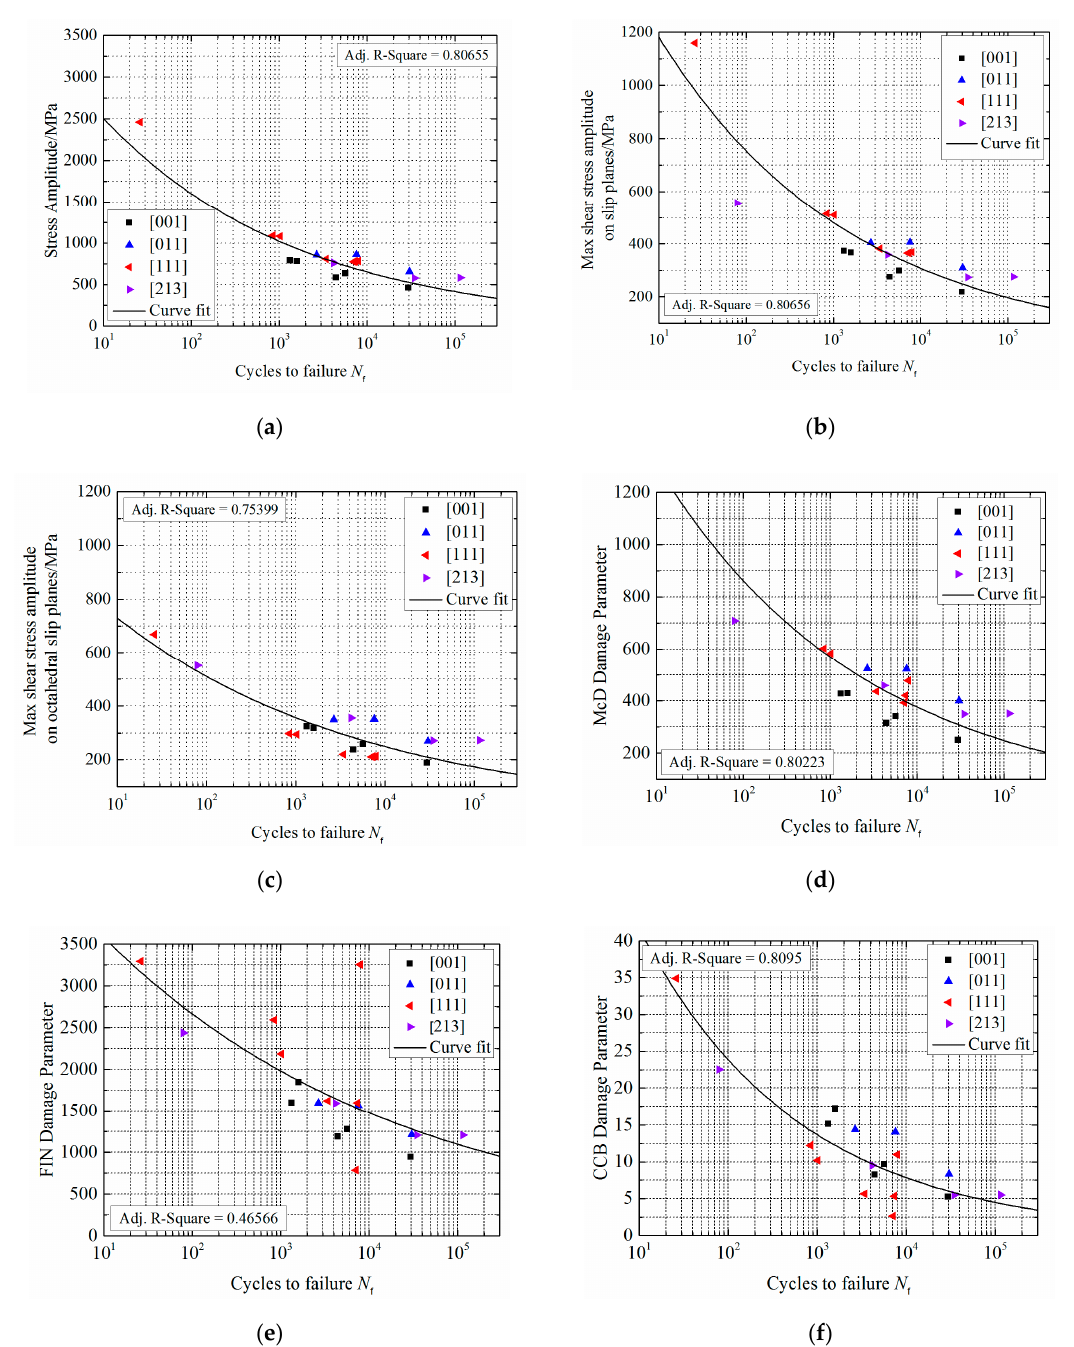
Figure 6. Fatigue life predictions for PWA1480 material at 648 °C: ( a ) stress amplitude; ( b ) maximum resolved shear stress amplitude; ( c ) maximum resolved shear stress amplitude (primary octahedral slip system); ( d ) McD model; ( e ) Fin model; ( f ) CCB model.